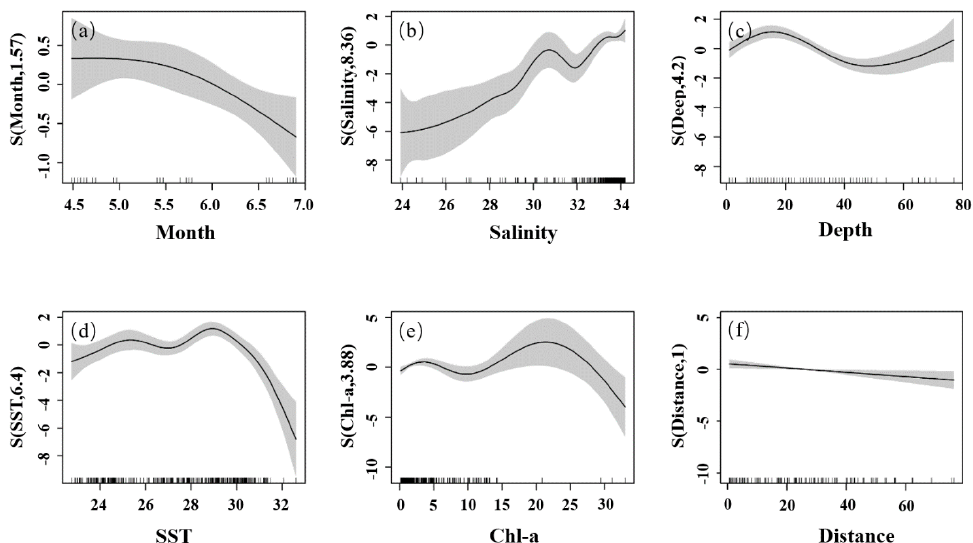
Figure 2. A generalized additive models (GAMs) analysis of the effects of the spatiotemporal and environmental factors on the fish-egg density in WGWs: ( a ) month, ( b ) seas surface salinity (SSS), ( c ) depth, ( d ) sea surface temperature (SST), ( e ) chlorophyll concentration of a (Chl-a), and ( f ) distance. Shadow areas, 95% confidence intervals. Rug plots on the x-axis indicate data density.